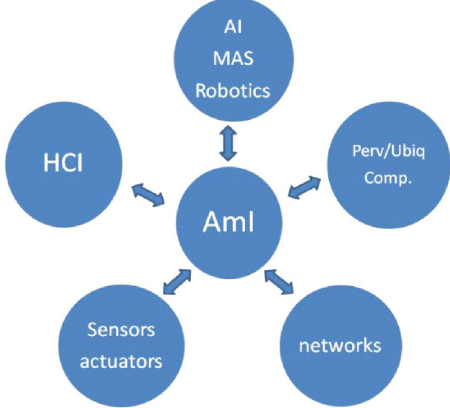
Figure 2. AmI is a multidisciplinary area, each of them highly complex in itself.